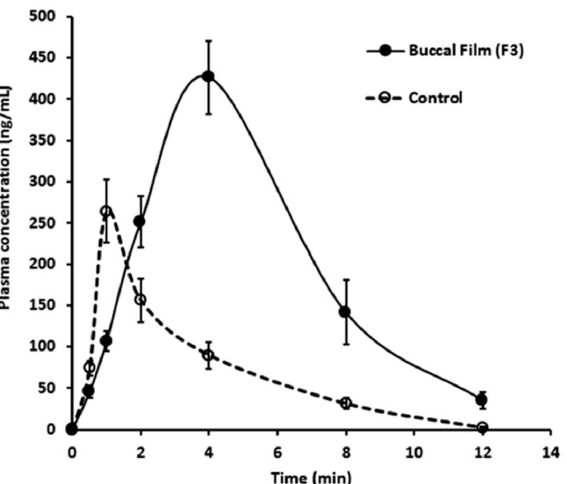
Figure 6. Comparison of the plasma profiles of selegiline following the buccal application (4 h) of nanosphere-loaded buccal film and control solution via the oral route in rabbits (Reproduced from [127], Taylor & Francis, 2014).